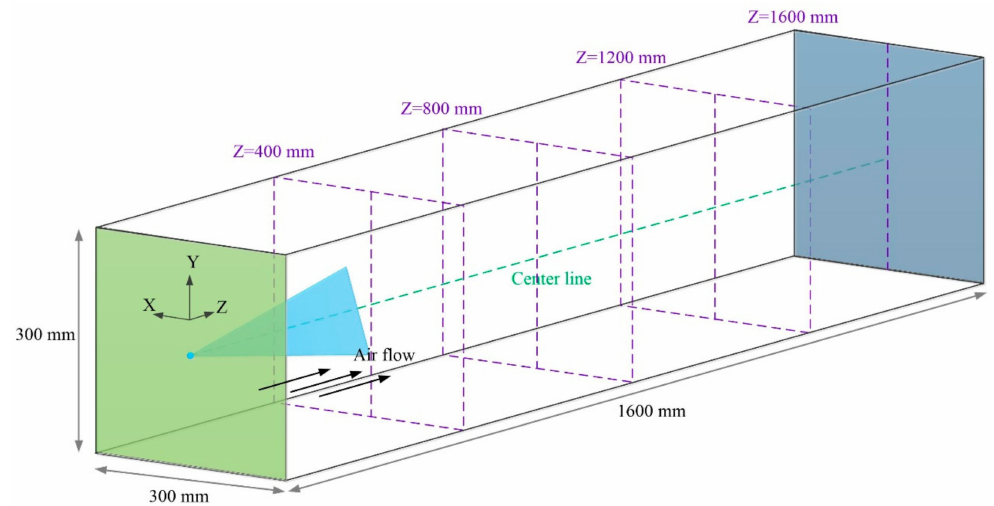
Figure 4. Computational geometry.